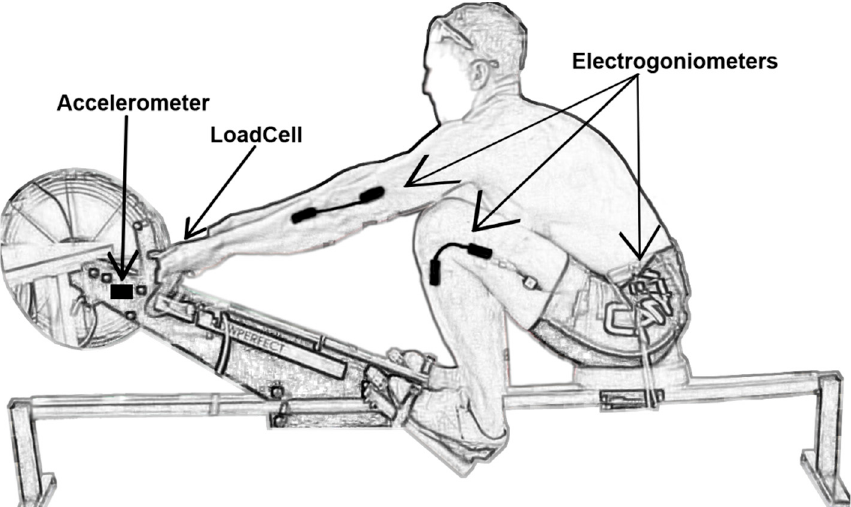
hip, and flexion of the